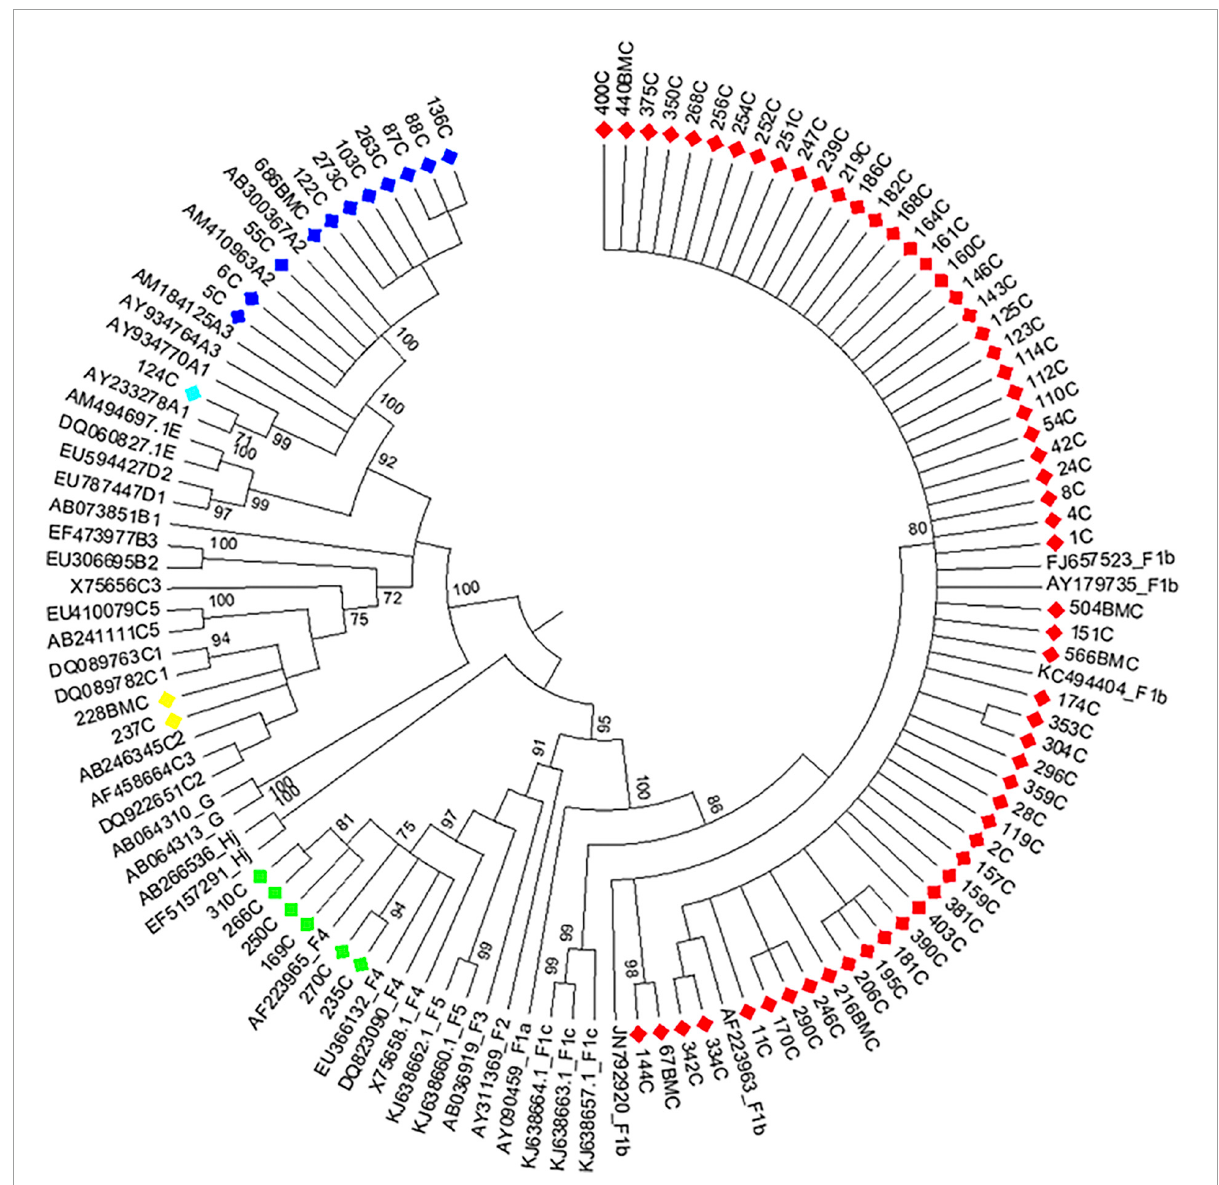
FIGURE1 Maximum likelihood phylogeny of acute hepatitis B samples from Córdoba, Argentina. Maximum likelihood phylogenetic tree obtained using sequences of 1,169 nucleotides, resulting from concatenated sequences of the S (471 nucleotides) and BCP-pC genomic regions (698 nucleotides) of acute hepatitis B samples from central Argentina and reference sequences from each genotype or subgenotype available at GenBank. The phylogenetic tree was constructed with MEGA v.6 (bootstrap: 1000 replicates). References: A1, light blue; A2, blue; C, yellow; F1b, red; F4, light